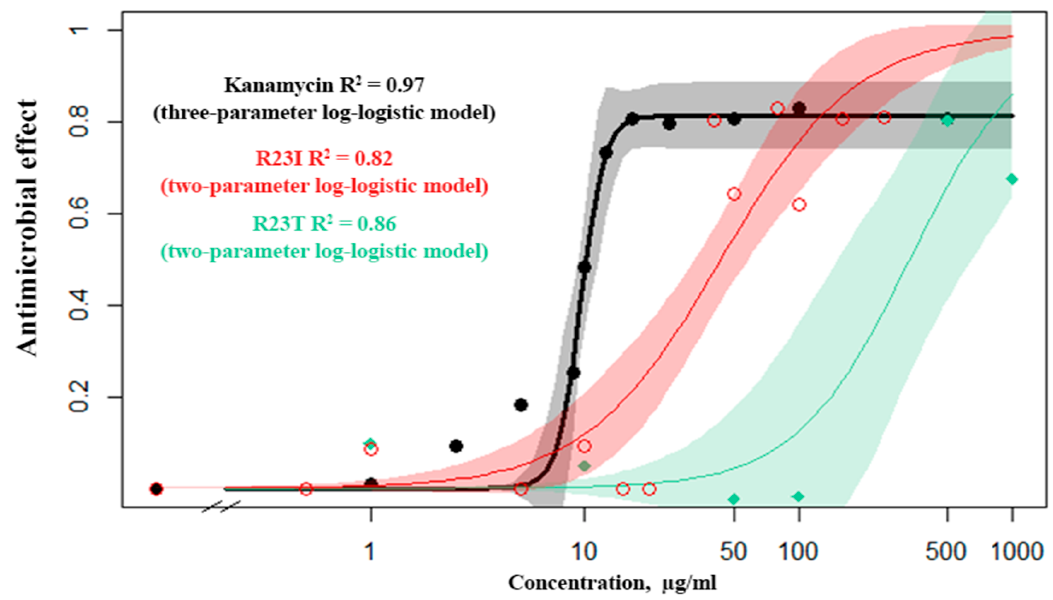
Figure 4. Response curves of T. thermophilus cells to the action of kanamycin (black), R23I (red), R23T (green) peptides. (green)